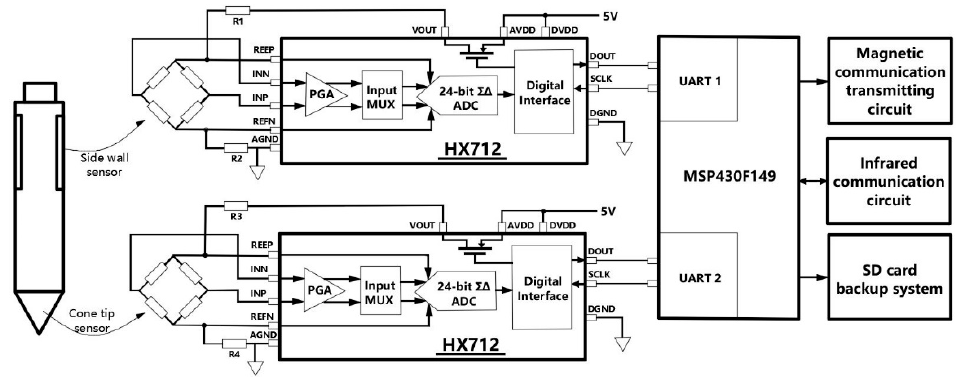
Figure 5. Circuit diagram of the data collector in the CPT